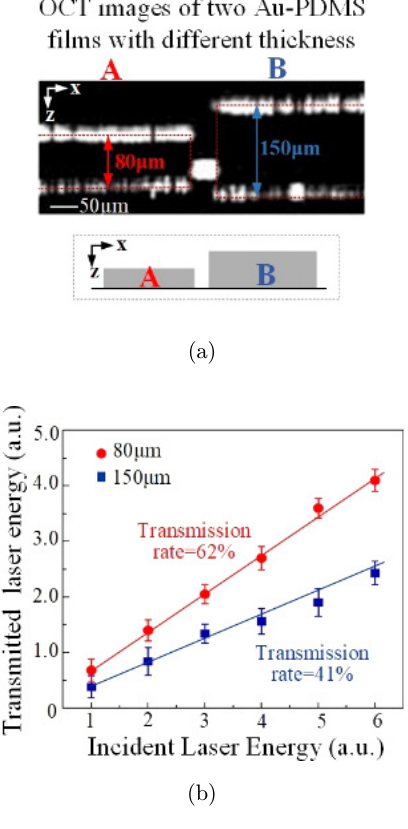
Fig. 2. Optical characterization of gold-PDMS ¯lms. (a) OCT images of two gold-PDMS ¯lms with di®erent thickness. (b) Optical transmissivity of two gold-PDMS ¯lms.